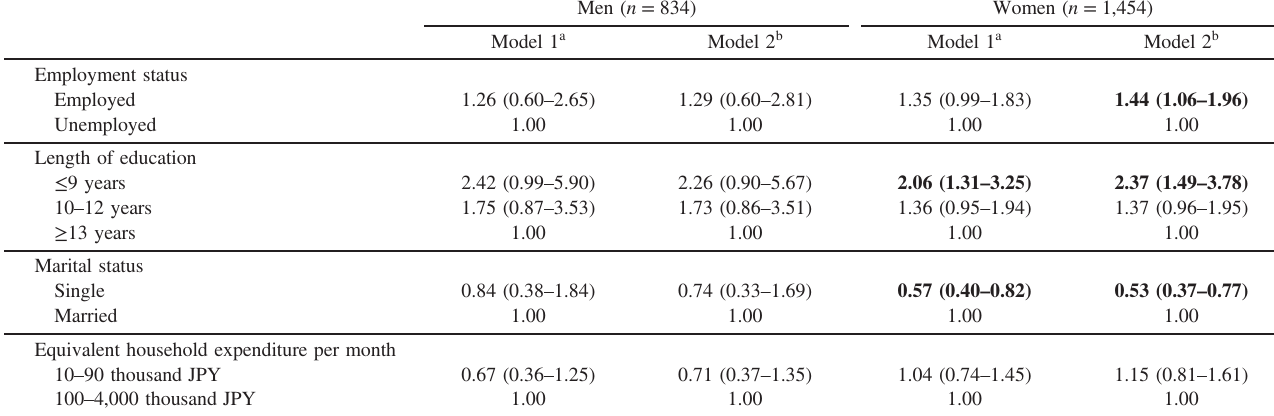
Table 3. Odds ratios (95% con fi dence intervals) of passive smoking at home for socioeconomic status by sex, NIPPON DATA2010 ( n =